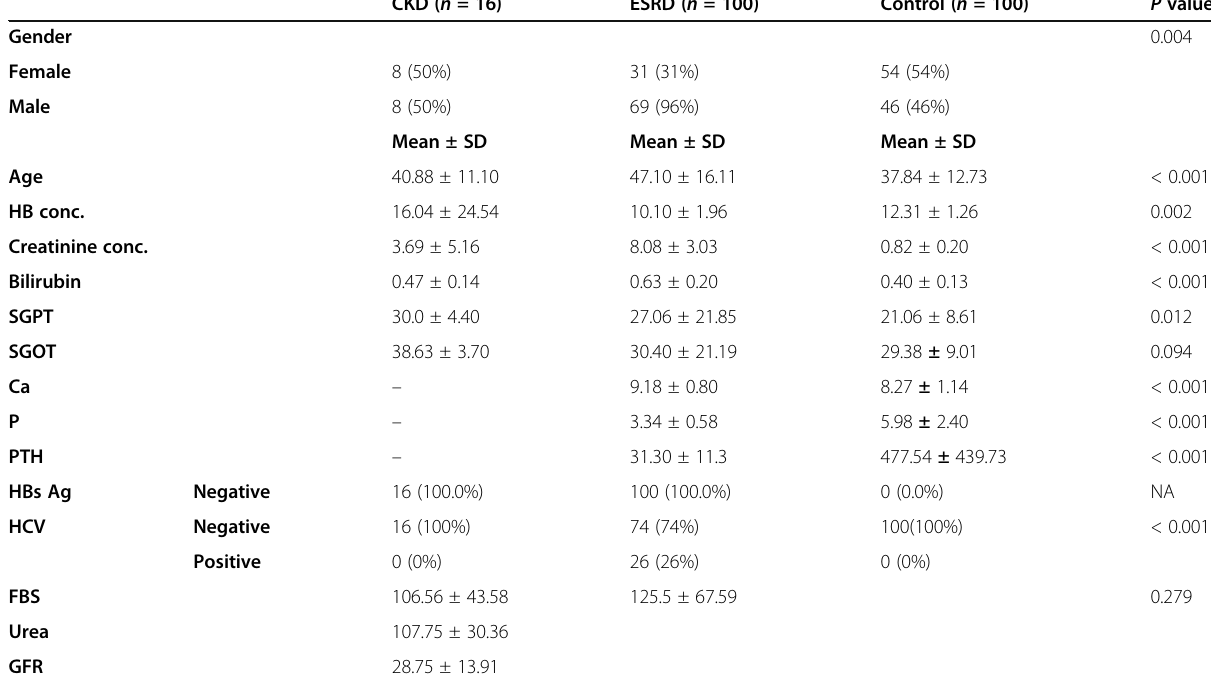
Table 1 Clinical characteristics of studied